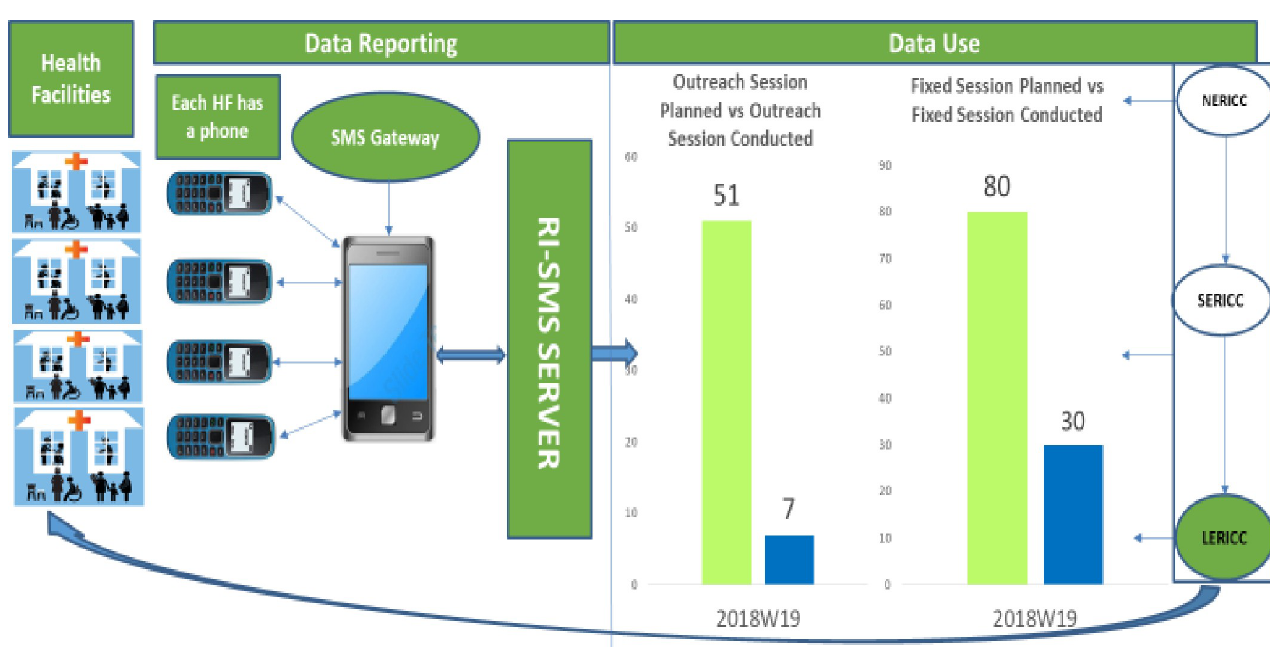
Fig 1. Information flow chart for the SMS reporting